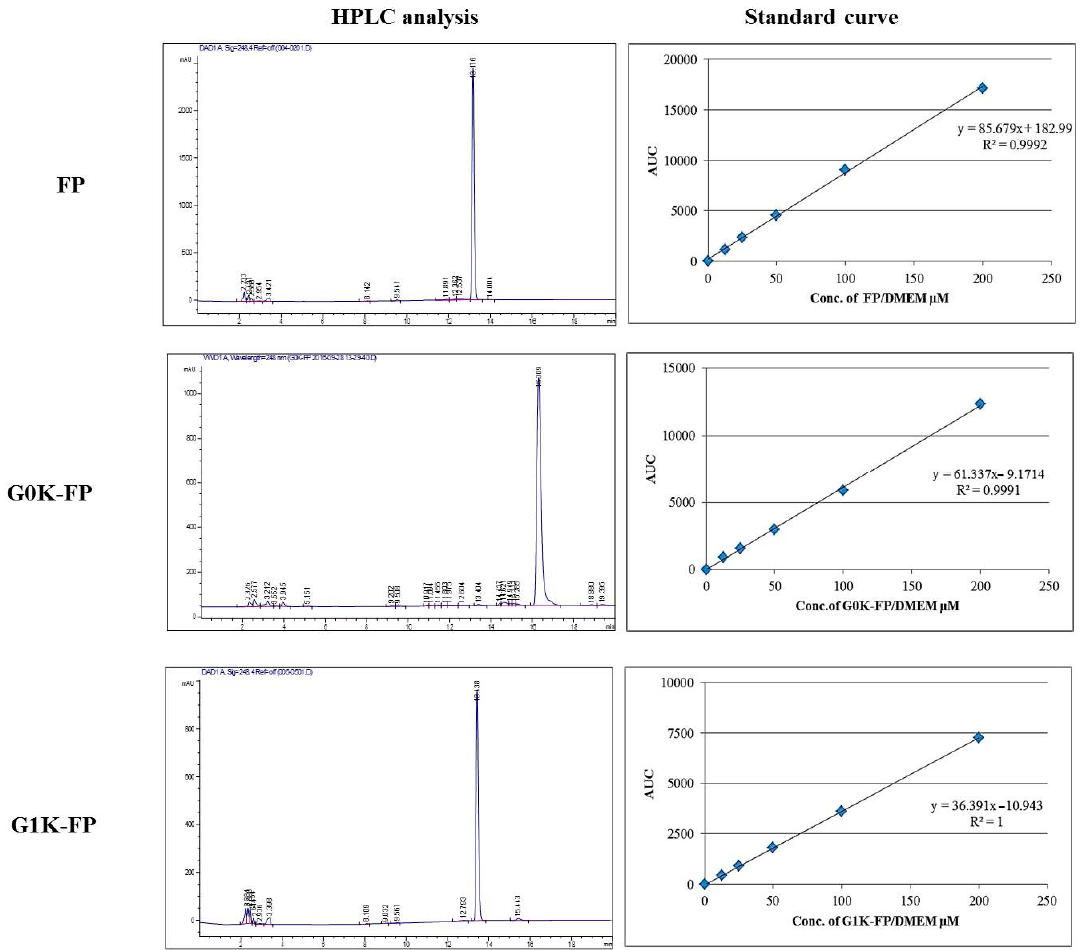
Figure 6. HPLC analysis and corresponding standard curve of FP, G0K-FP, and G1K-FP. Table 2. Quantification of γ -secretase enzyme after exposure to free FP, G0K-FP and G1K-FP.